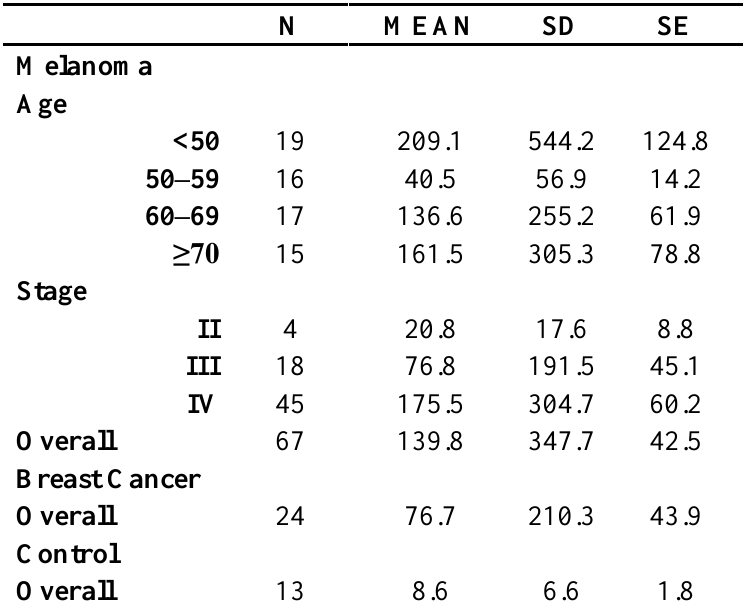
Table 1. Comparison of serum IL-8 levels (pg/mL) by